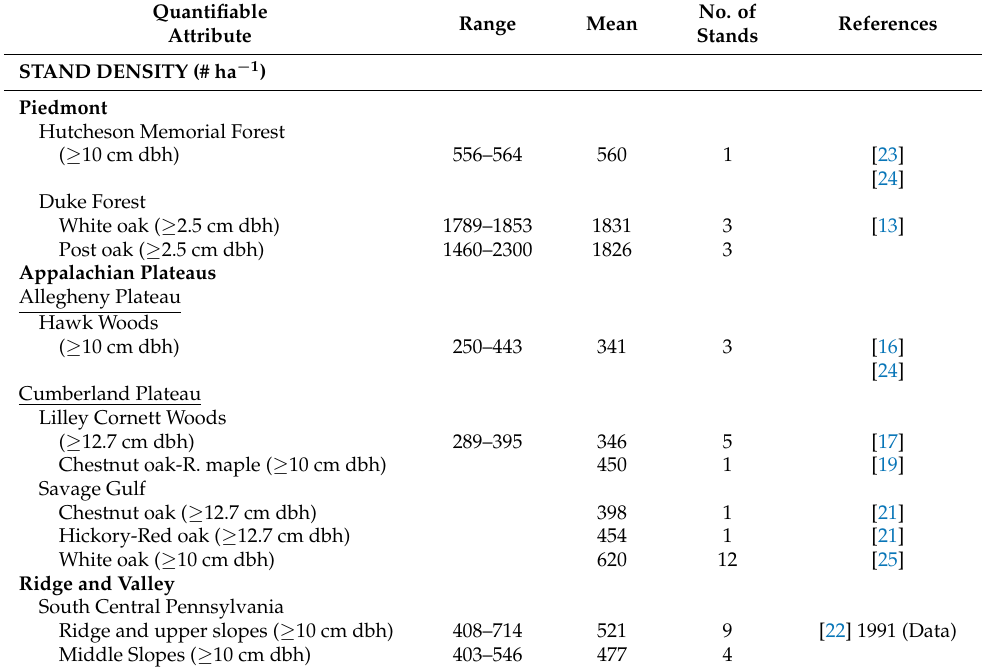
Table 1. Stand density (# ha − 1 ) of representative dry-mesic old-growth oak forests. Quantifiable